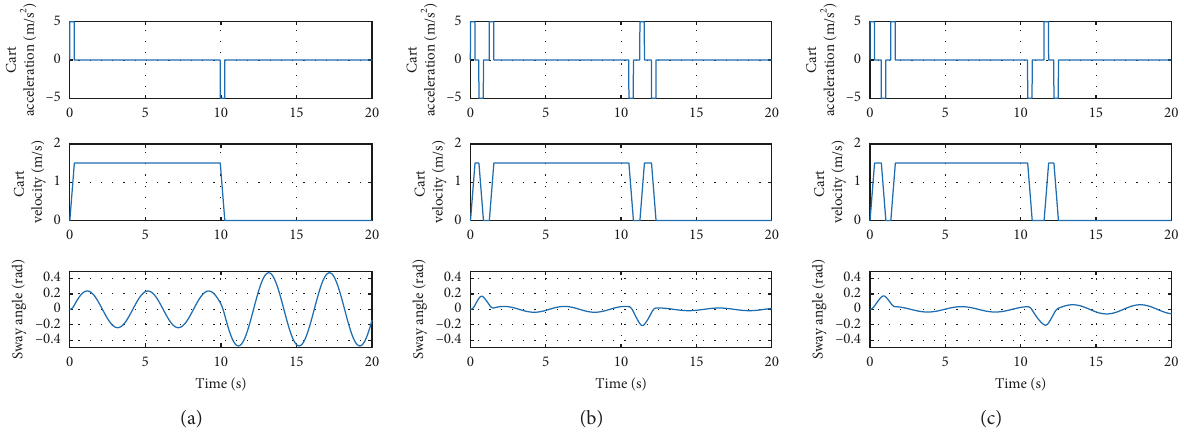
Figure 10: Experimental results which subject A-1 attempts to operate the cart in case of training with sway angles displayed in the simulator. (a) The experimental results in 5th attempt before training. (b) The experimental results in 1st attempt after training. (c) The experimental results in 1st attempt after changing to rope length 5